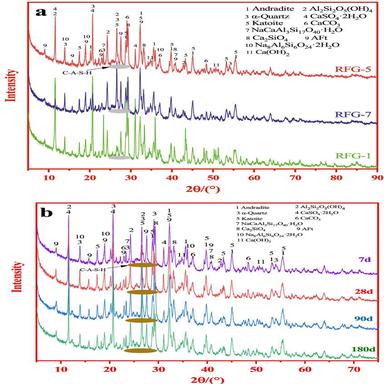
XRD patterns of (a) RFG-1, RFG -5 and RFG -7 after curing for 7 days and (b) RFG-5 at different curing time.